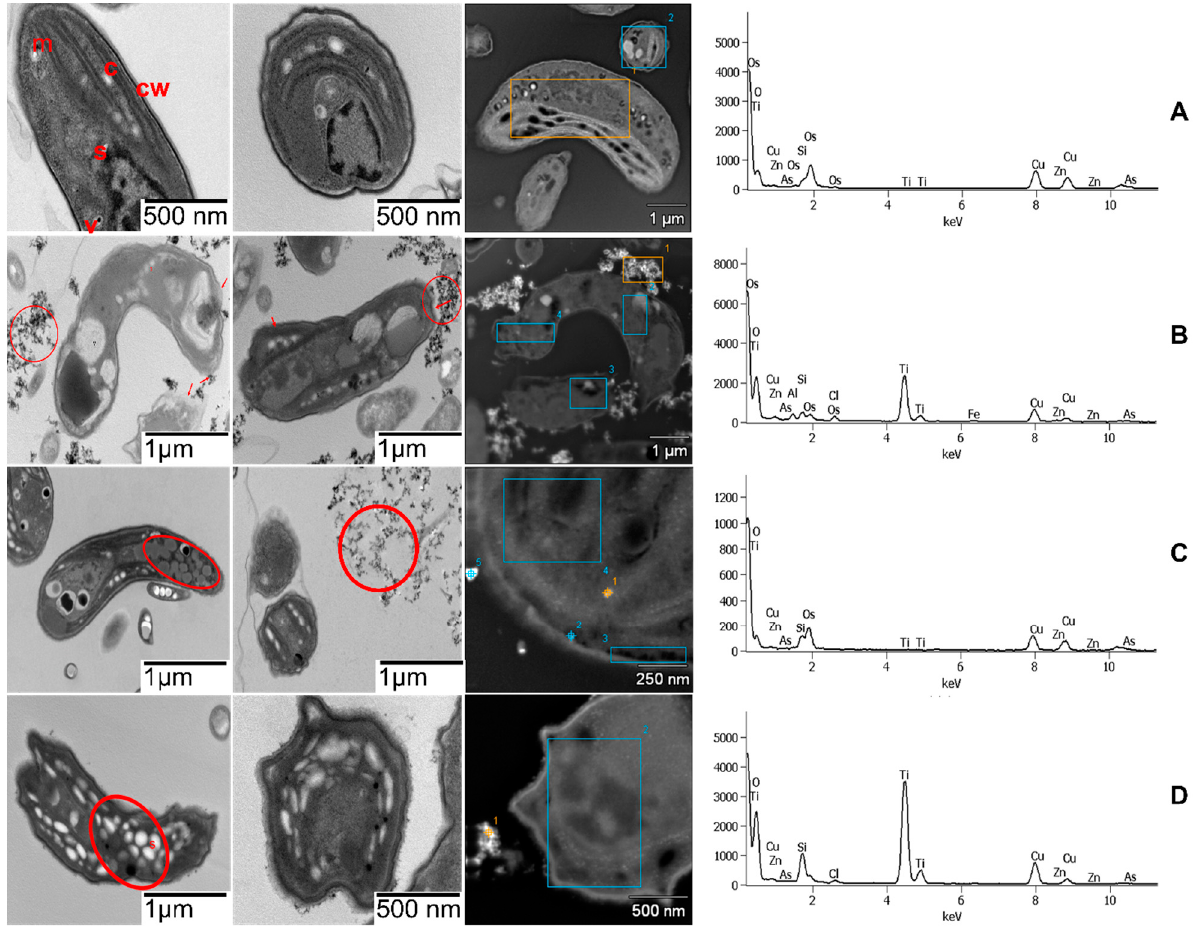
Figure 6. TEM-EDS images of cross-sections of unaffected P. subcapitata control (m = mitochondrion, c = chloroplast, s = starch grain, cw = cell wall, v = vacuole, n = nucleus) (row A ) and P. subcapitata exposed to 10% ( v / v ) of PR-ENMs of SUN1 (row B ), SUN2 (row C ) and SUN3 (row D ). The red arrows or circle indicate the adverse effects (slight morphological deformation, high lipid bodies, and starch grains) induced by SUNs PR-ENMs aggregates after 72 h exposure.